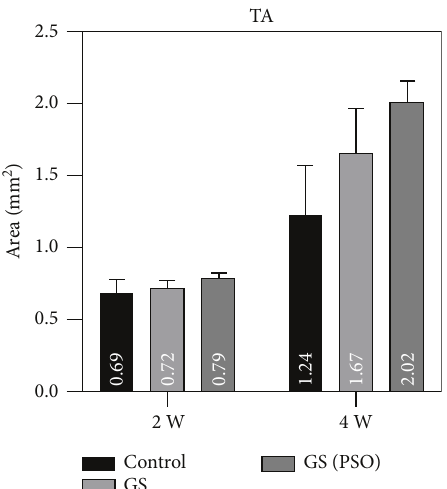
Figure 9: A bar chart representation of the mean and standard deviation of bone cells after 2- and 4-week time intervals for os- teocyte, considering the C, GS, and GS/PSO groups.